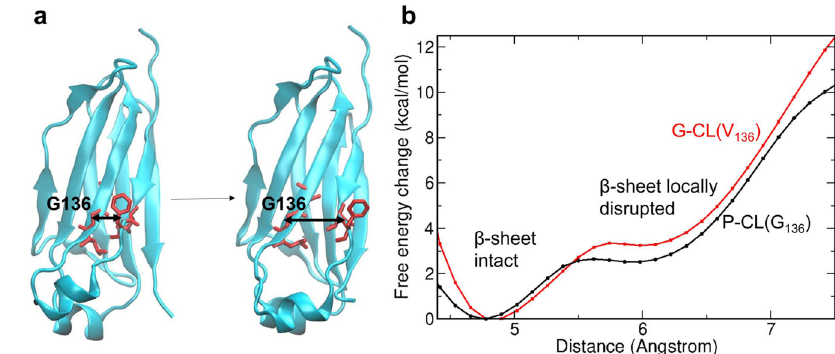
Fig. 4 Free energy simulations on P-CL and G-CL. a Umbrella sampling free energy simulations on partial dissociation of the N-terminal β -strand near the location of residue 136 were performed on the P-CL and G-CL (cartoon illustration) variants. The center of mass (com) distance between backbone atoms of residues 135 – 137 and residues 120 – 121 (red sticks) served as the reaction coordinate (double arrow). b Calculated free energy changes (potential of mean force) along the reaction coordinate for P-CL (black line) and G-CL (red line). Single simulations were performed ( n = 1). Source data are given in the Supplementary Data fi le.